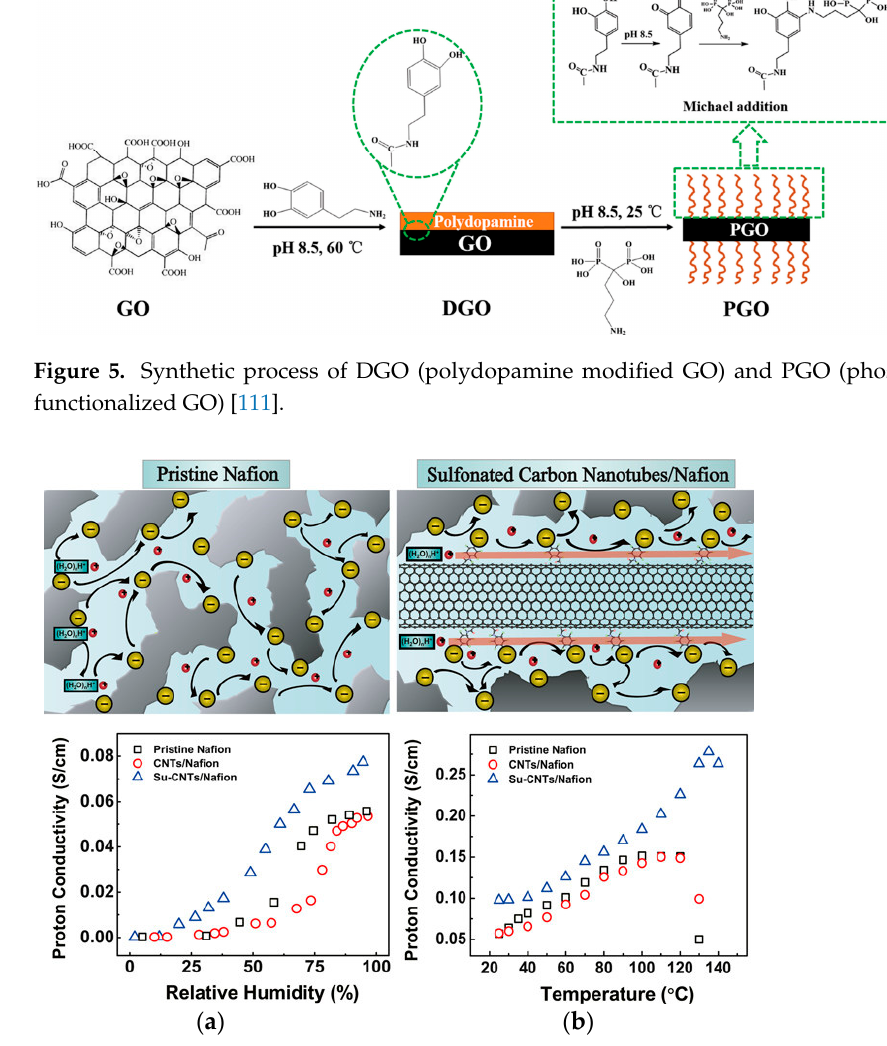
Figure 6. Schematic illustrations of proton transportation in water-hydrated ( a ) pristine Nafion mem- branes with tortuose proton pathways and ( b ) Su-CNTs/Nafion membranes with proton highways along Su-CNTs